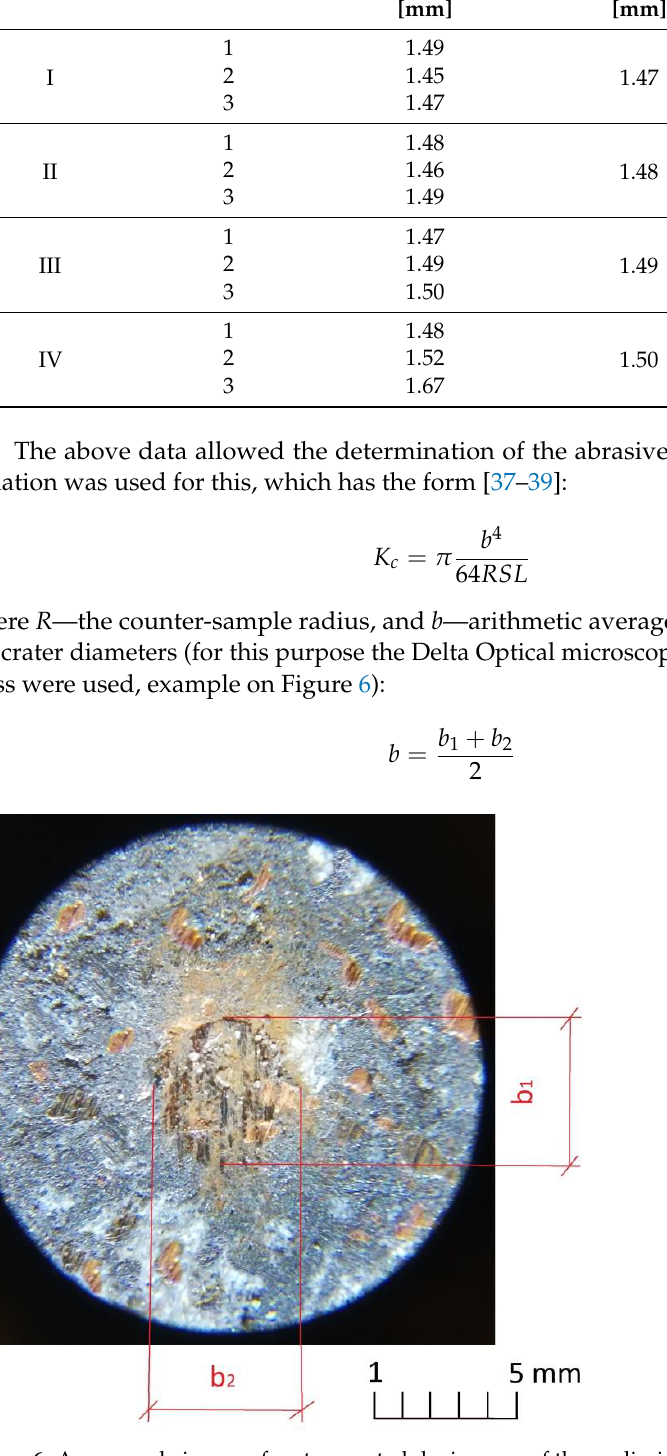
Figure 6. An example image of crater created during one of the preliminary test runs. The results of calculations of K c for all four groups of samples are shown in Table 7.